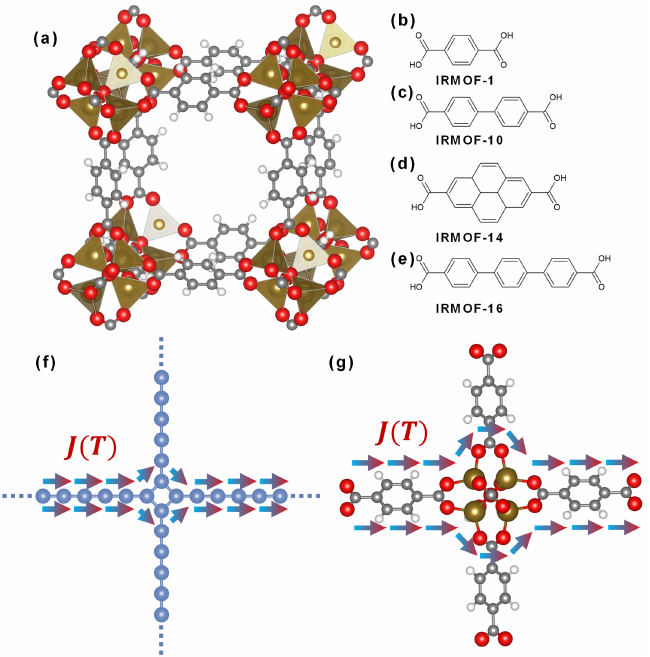
Figure 1. Atomistic structures of the MOFs and MOF building blocks investigated in this work: ( a ) IRMOF-1, ( b ) 1,4-benzenedicarboxylic acid to form IRMOF-1, ( c ) biphenyl-4,4 ′ -dicarboxylic acid to form IRMOF-10, ( d ) pyrene-2,7-dicarboxylic acid to form IRMOF-14, and ( e ) terphenyl-4,4 ′ ’- dicarboxylic acid to form IRMOF-16. ( f ) Two-dimensional slice of the atoms in a node and its neighboring linkers for a model system with easily adjustable linker length. The system is de- signed such that its heat transport pathways for the heat flux, J(T) , are similar to real Zn 4 O-based MOFs, like those in IRMOF-1 ( g ). Colors representing the different atom types: Zn—brown, C— grey, H—white, O—red, model “atoms”—light blue.